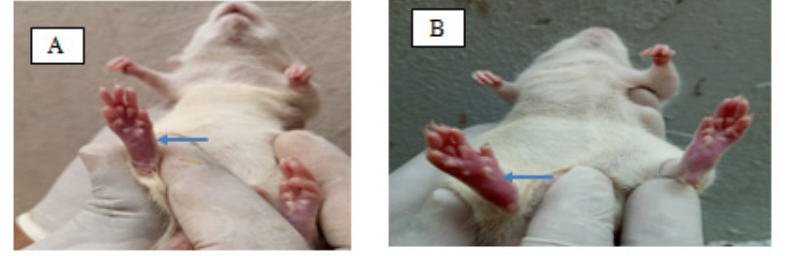
Table 4. Stability studies of P. granatum ethosome gel.